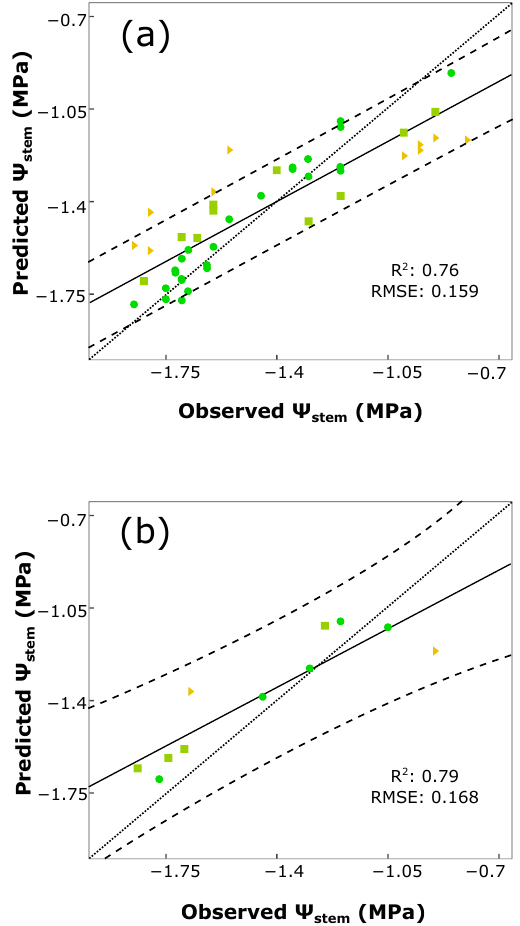
Figure 3. Regression plot for ψ stem estimation of the variety-specific model (Tempranillo) using a Rotation Forest and M5 trees with a 5-fold cross ( a ) and external ( b ) validations. Prediction confidence bands are shown at a 95% level (dashed lines). Solid line represents the regression line and dotted line refers to the 1:1 line. Each points’ color and shape refers to its absolute error value | ε | (the absolute value of the difference between the actual value and the predicted one) in MPa: green minimal error; olive (cid:4) : 0.1 ≤ | ε | < 0.2, low error; orange | ε | ≥ 0.4, high